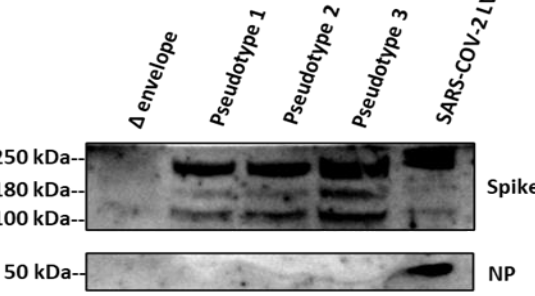
Figure 2. Incorporation of SARS-CoV-2 protein into pseudotypes. The spike protein of the particles was investigated by Western blotting. From left to right: lanes showing Δ-envelope pseudotype; SARS-CoV-2 Pseudotype batch 1, batch 2, batch 3; and SARS-CoV-2 live virus (LV). The LV was used as a positive control and the Δ-envelope (particles bearing no envelope protein), prepared with the same procedure, was used as a negative control. Uncleaved S protein, about 180 kDa; cleaved S protein, about 100 kDa; dimeric-trimeric S protein, above 250 kDa; Nucleocapsid protein, about 50 kDa. Experiments were done twice and one is shown.